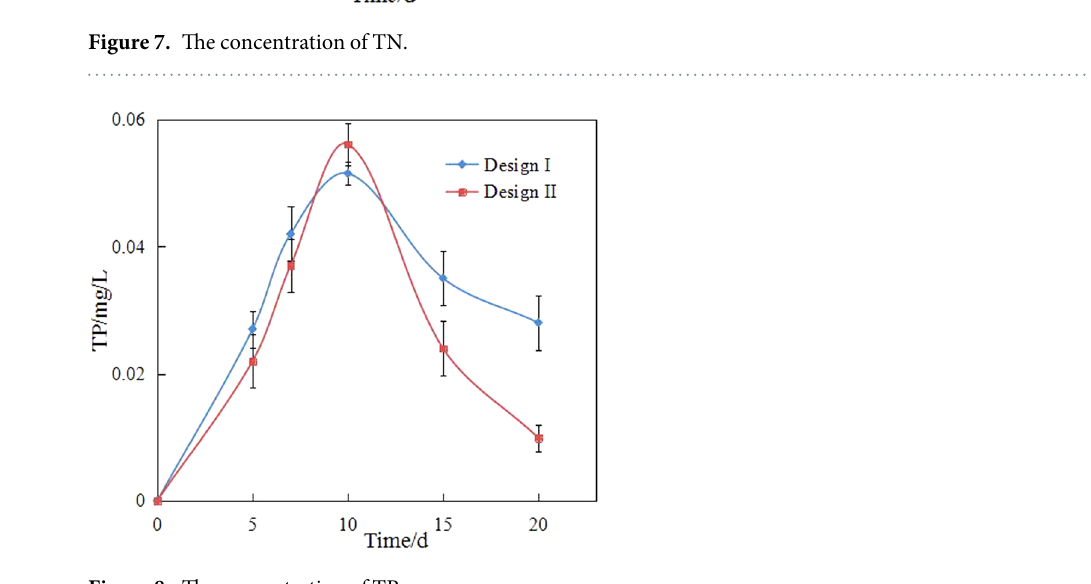
Figure 8. The concentration of